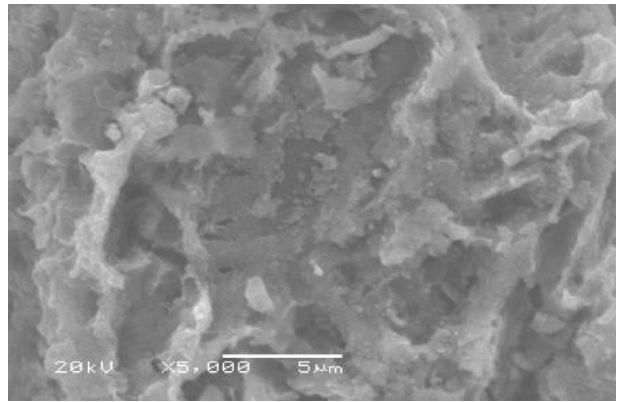
Figure 3. Image microscope photograph of LCF.